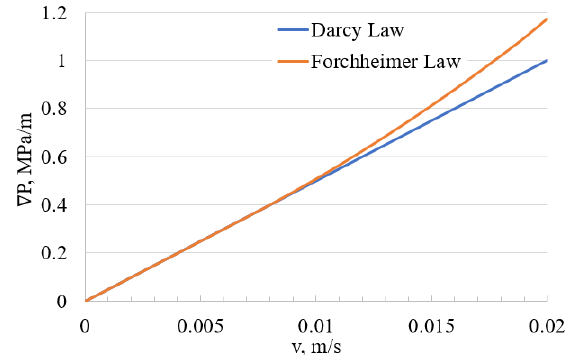
Figure 1. Relationship between pressure gradient and velocity.